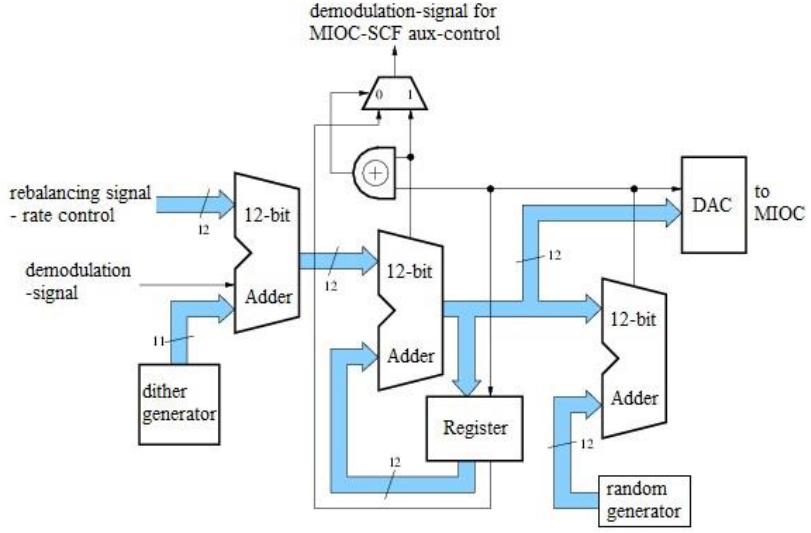
Figure 15. Configuration for mean-value-free 4π-modulation.